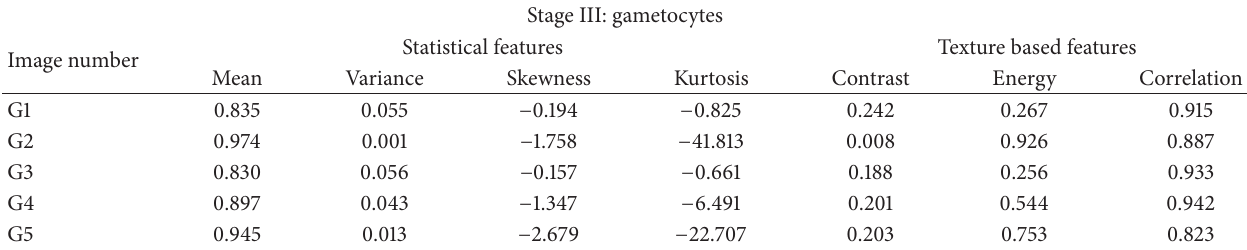
Table 3: The values obtained while training dataset for stage III. Stage III: gametocytes